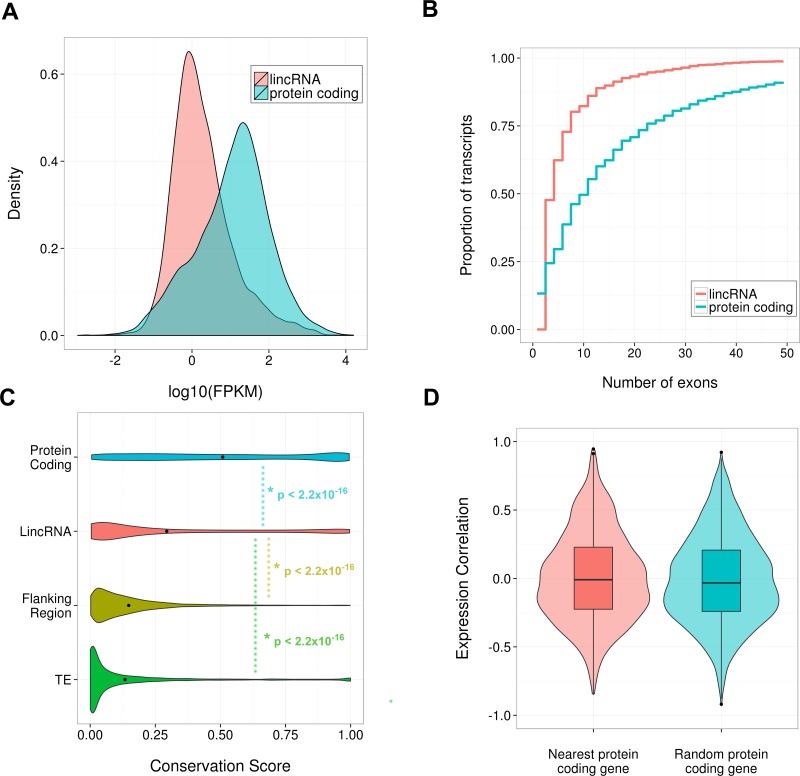
Properties of identified SCN lincRNAs.(A) Density plot comparing the distribution of expression levels of the 3187 identified lincRNAs (red) and protein-coding genes (blue); lincRNAs tend to be significantly lower expressed than protein-coding genes (p < 2.2×10-16, Kolmogorov–Smirrnov (KS) test). (B) Cumulative frequency graph showing the number of exons possessed by protein-coding genes and the identified 3187 lincRNA loci. Despite this study only considering multiexonic lincRNAs, protein-coding genes tend to possess significantly more exons (p < 2.2×10-16, KS test). (C) Violin plot showing phastCons conservation scores for the exonic regions of the 2796 identified lincRNAs with available conservation scores; these lincRNAs showed significantly less conservation than protein-coding genes but significantly greater conservation than two proxies for neutral evolution: (i) transposable elements within a 50-kb window of the lincRNA locus (p < 2.2×10-16, KS test), (ii) 500-bp of sequence up- or downstream of the lincRNA locus selected randomly within a 1- to 5-kb window (p < 2.2×10-16, KS test). (D) Violin and box plot showing no significant difference (p = 0.45, KS test) in the Pearson’s correlation of a lincRNA’s expression with that for its genomically most proximal protein-coding gene (n = 2261, expression correlation not possible if closest gene is not expressed) compared to a randomly selected protein-coding gene.